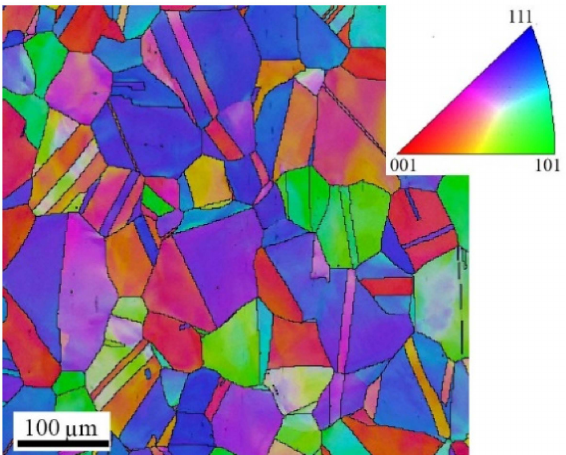
Figure 3. IPF image of the wrought 316L sheet microstructure consisting of coarse equiaxed austen- ite grains.